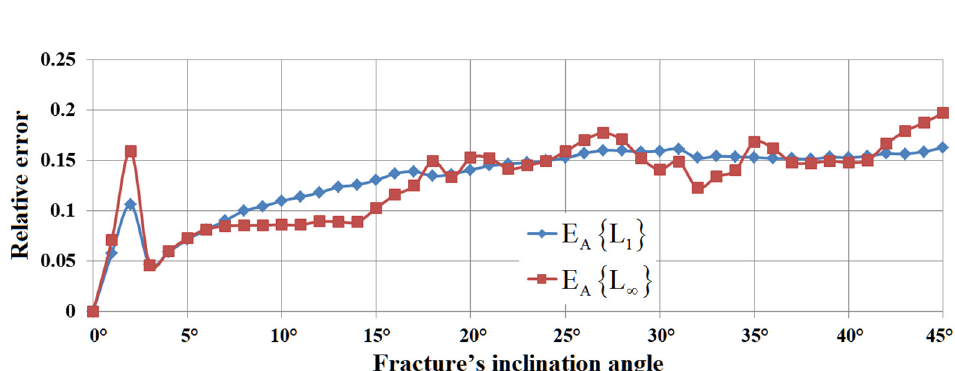
Figure 6. Dependence of the relative errors on the angle α.